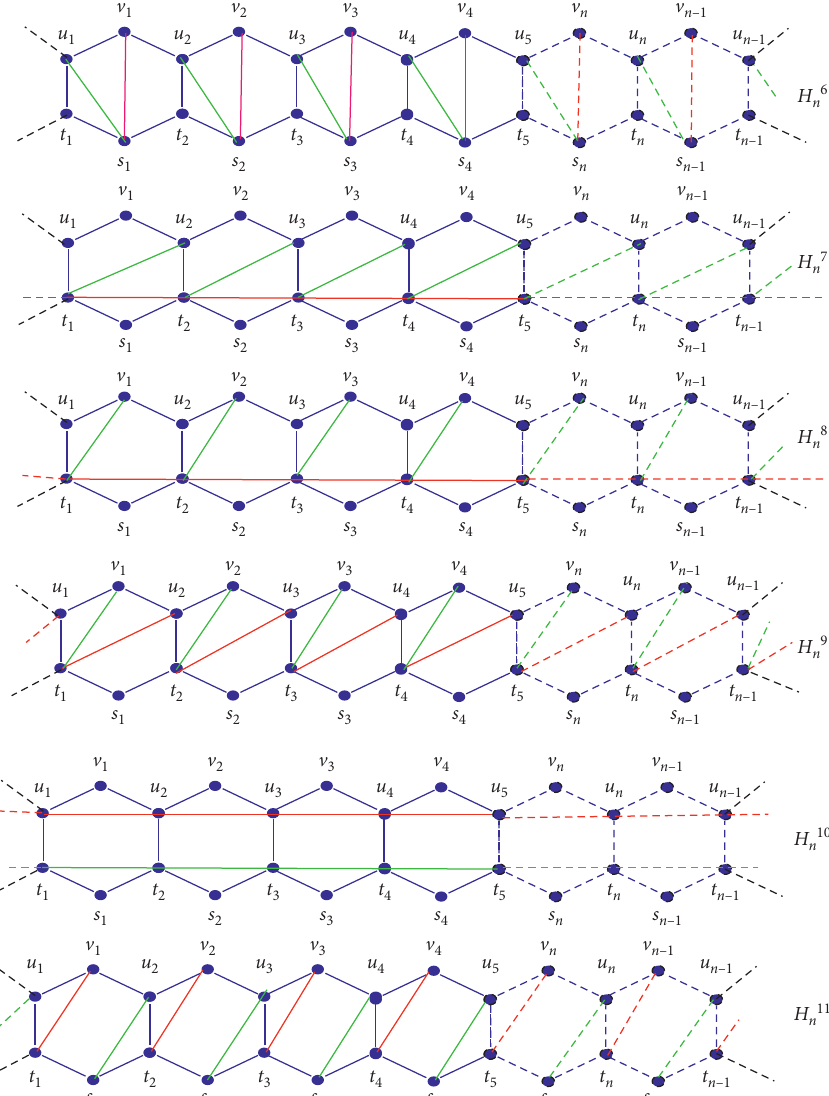
Figure 4: Rotationally symmetric hexagonal planar graphs with 4